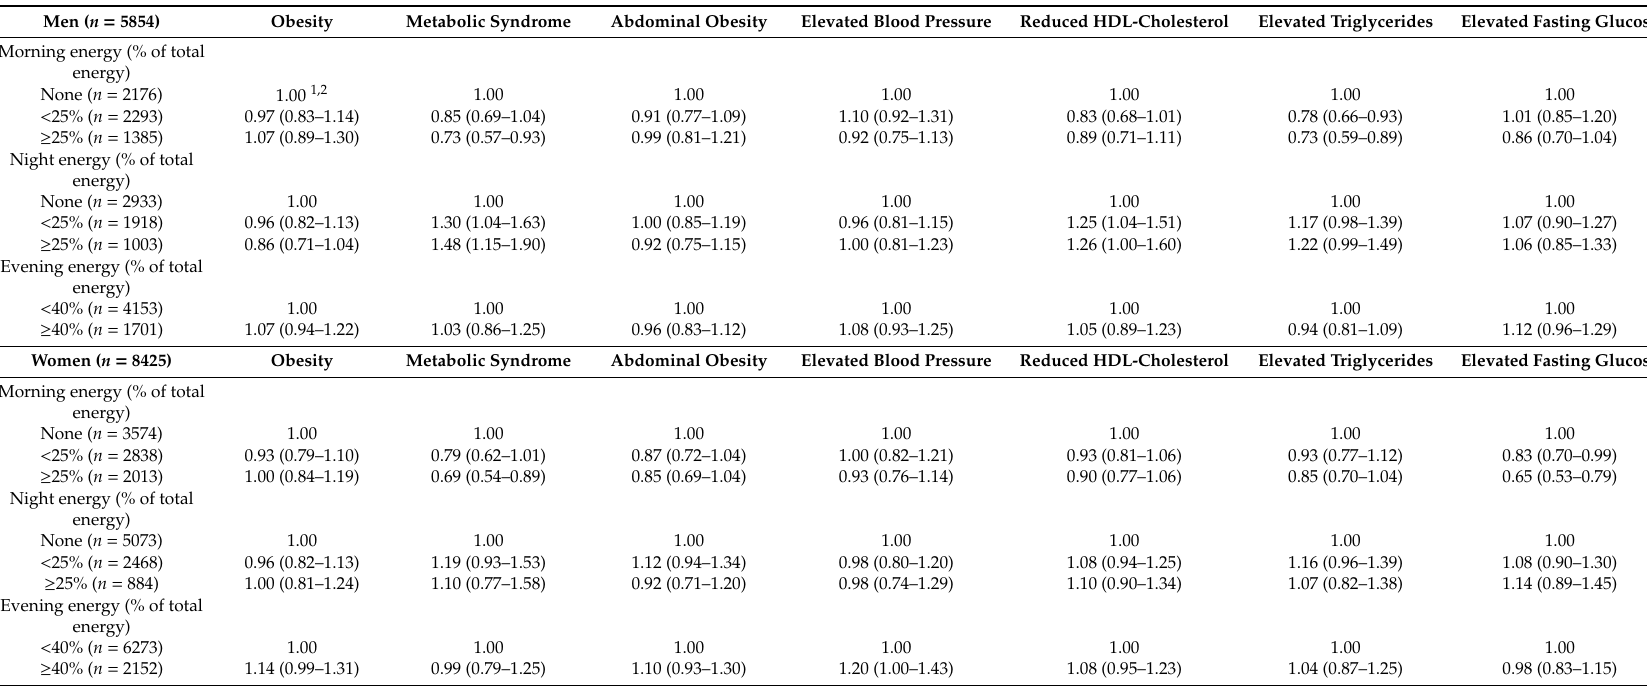
Table 3. Multivariable-adjusted odds ratios and 95% confidence intervals for obesity and metabolic syndrome according to energy intake in the morning, evening, and